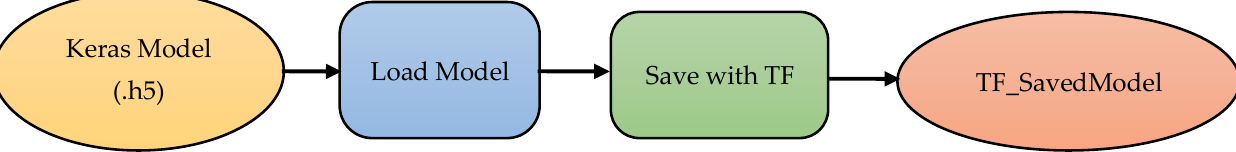
Figure 8. Deployment procedure on NCS2 where the pre-processed data and IR model is fed to the